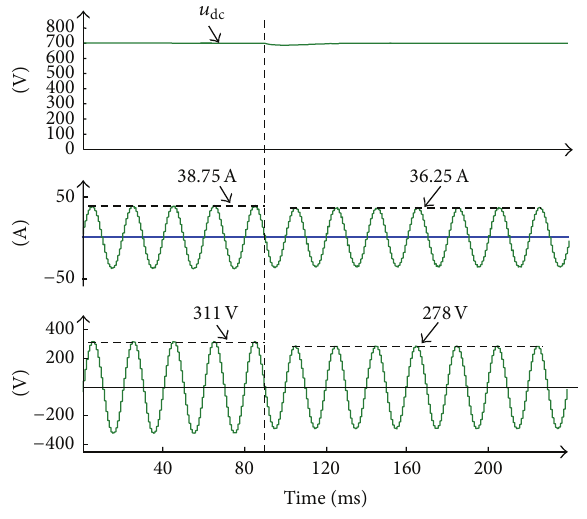
Figure 4: Wave of DC bus voltage and power grid current (power grid voltage dumps 10%).